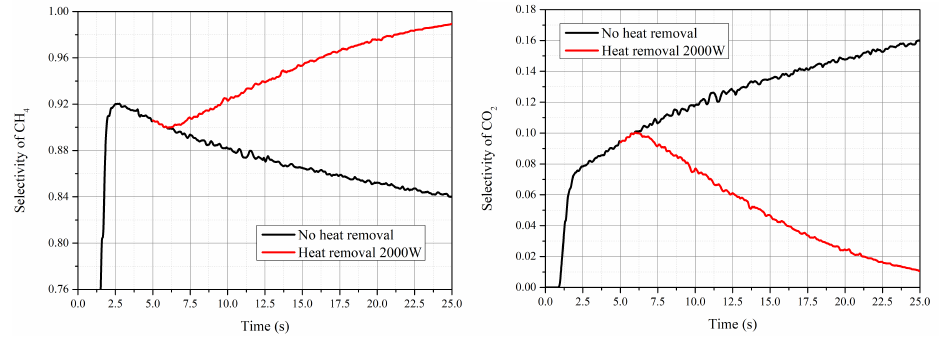
Figure 9. Time-evolution of selectivity of CH 4 ( left ) and CO 2 ( right